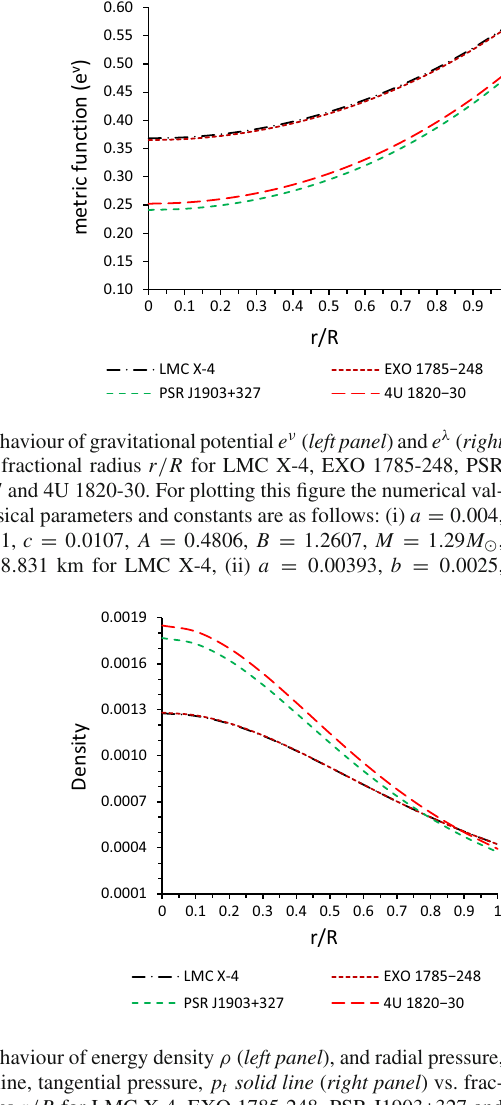
to anisotropy can be defined as F = 2 (cid:9)